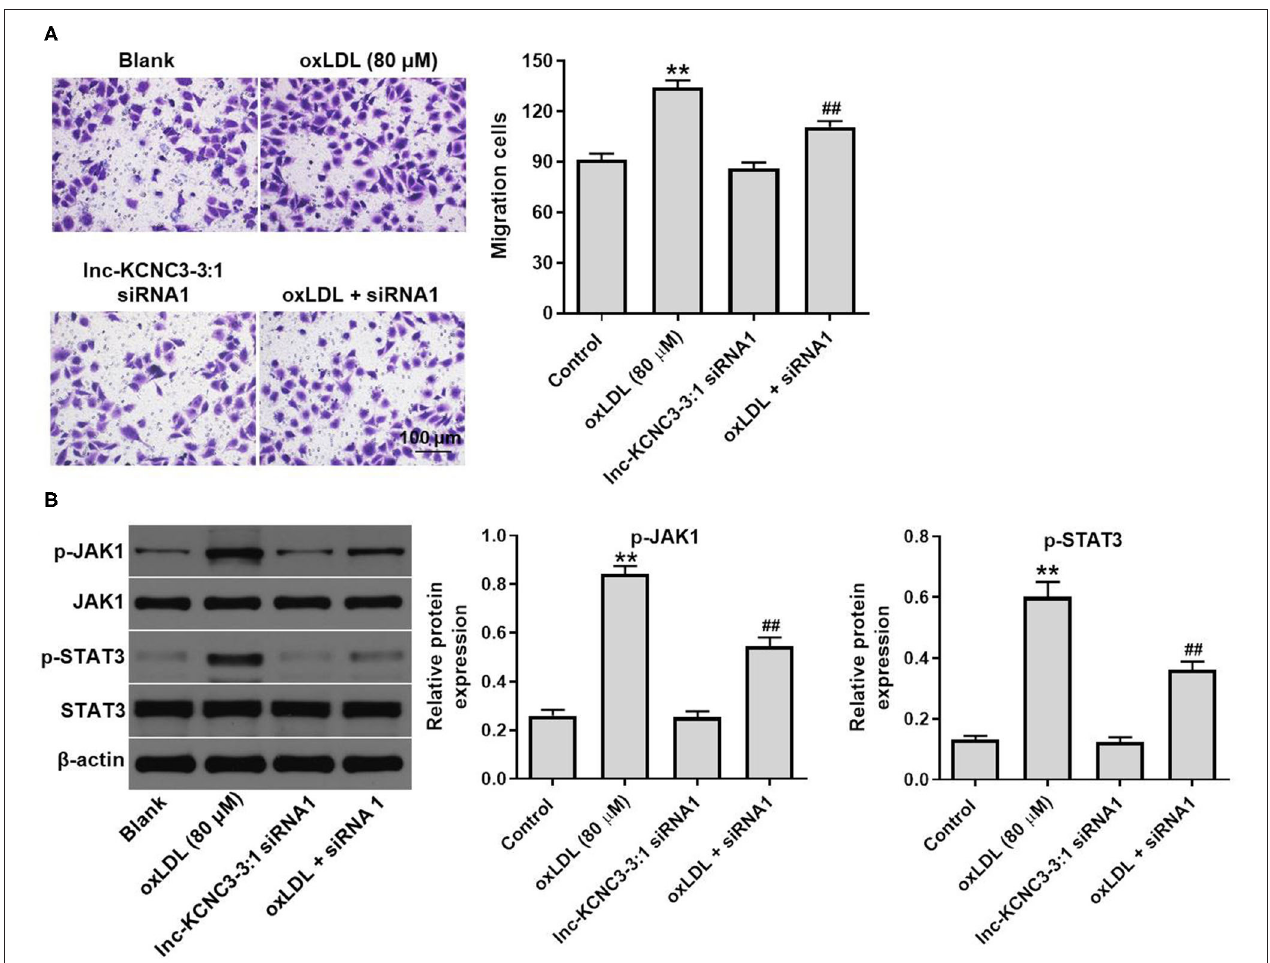
FIGURE 5 | Knockdown of lnc-KCNC3-3:1 inhibits oxLDL-induced cell migration via downregulation of JAK1/STAT3 pathway. HUVECs were transfected with lnc-KCNC3-3:1 siRNA1 for 6h s. Then, cells were treated with 80 µ g/mL of oxLDL for 24h. (A) Transwell migration assay was used to detect HUVEC cells migration ability. (B) Western blot was performed to measure the expressions of p-JAK1 and p-STAT3. ** P < 0.01 compared with control group. ## P < 0.01 compared with the atherosclerosis group, n =